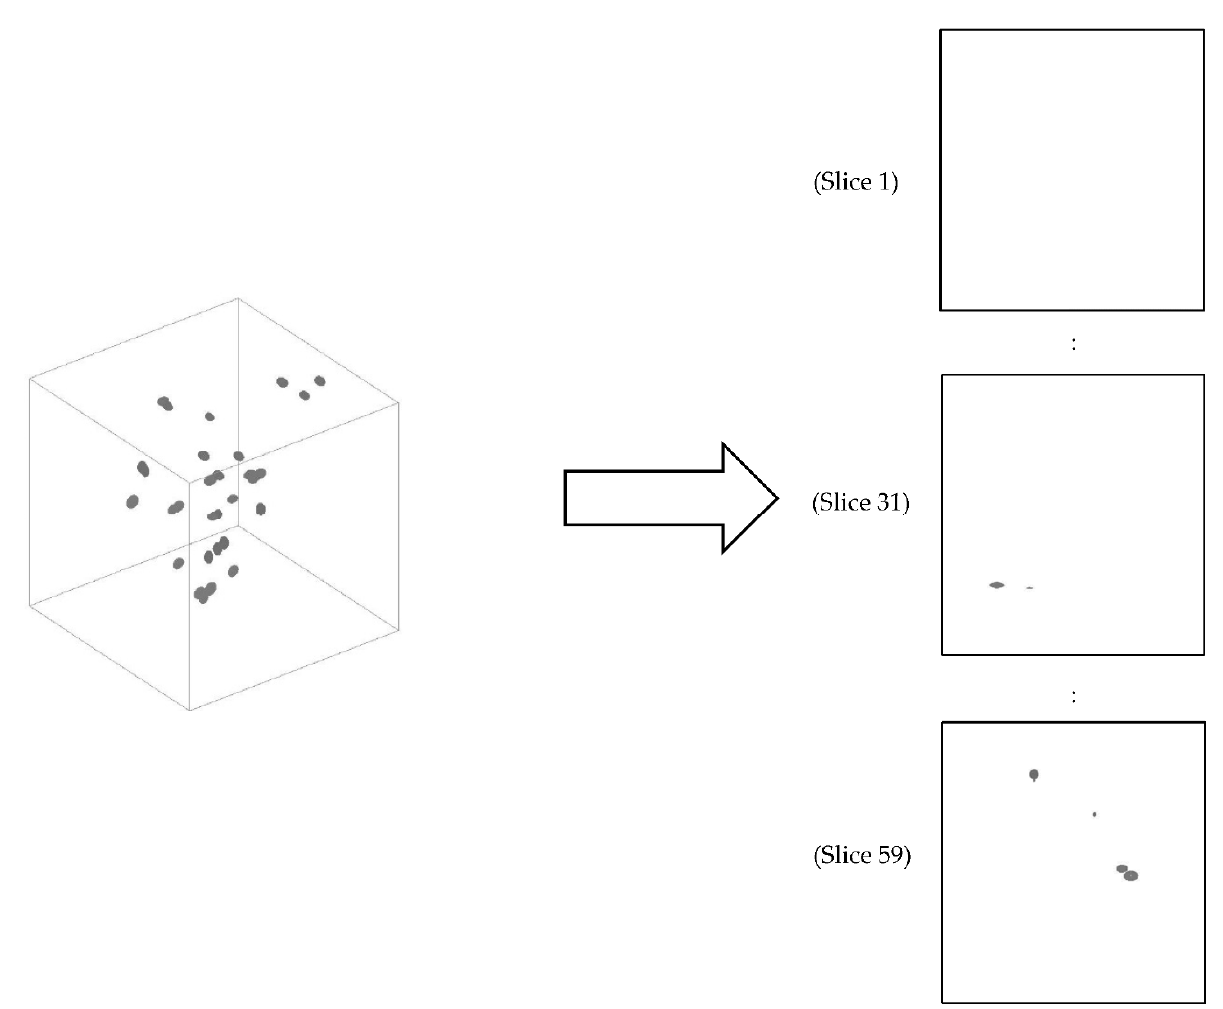
Figure 15. Illustrative example of the cube slicing.